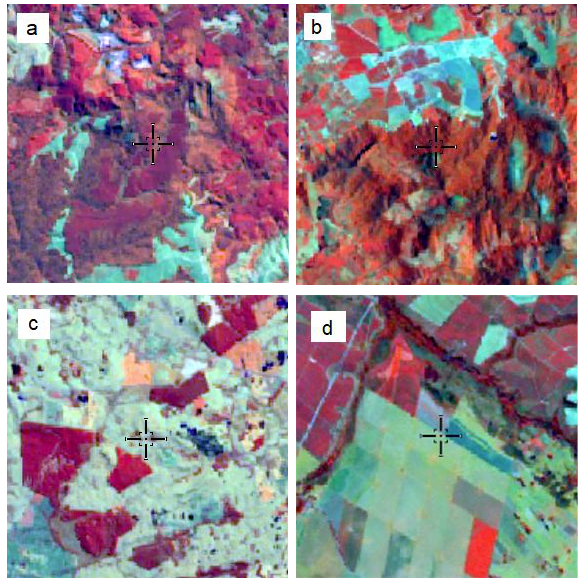
Figure 4a. Planted forest; Figure 4b. forest formation; Figure 4c. Grassland formation; Figure 4d. Cultivated